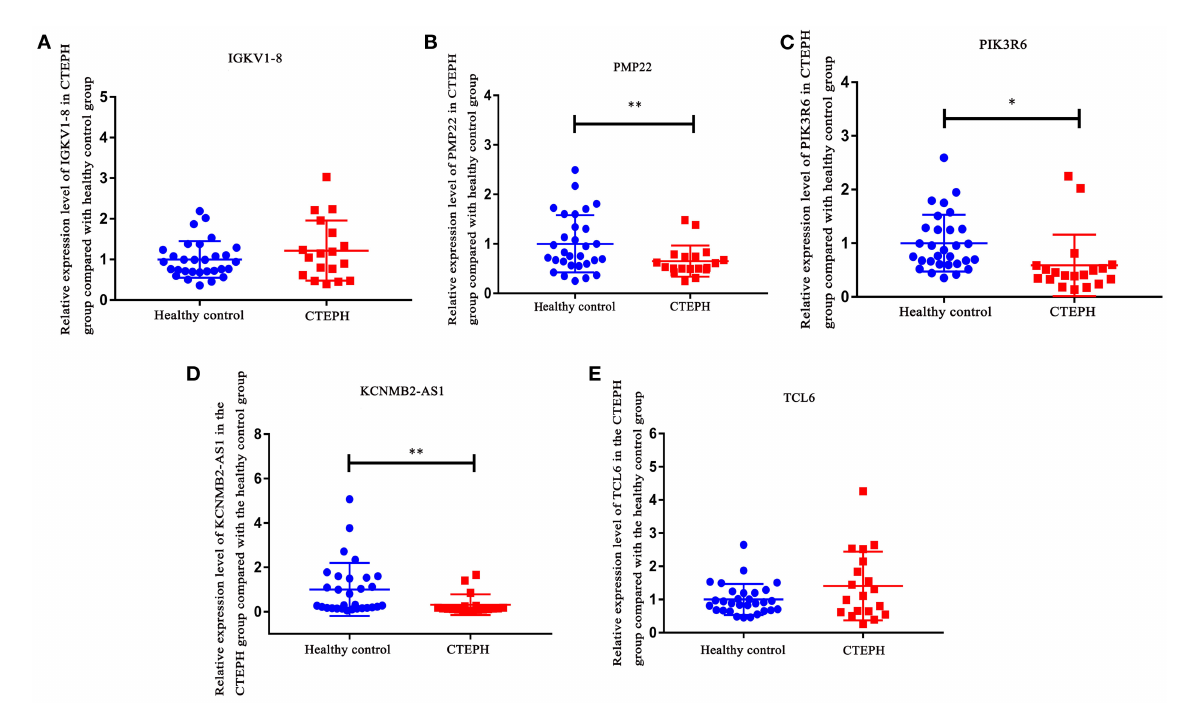
FIGURE8 RT-PCR validation of IGKV1-8 (A) , PMP22 (B) , PIK3R6 (C) , KCNMB2-AS1 (D) , and TCL6 (E) in blood samples. In comparison with the healthy controls, the expression levels of IGKV1-8 and TCL6 in CTEPH group were upregulated trend and PMP22, PIK3R6, and KCNMB2-AS1 were downregulated trend in CTEPH group. Statistical analysis of RT-PCR results showed that the changes in PMP22, PIK3R6, and KCNMB2-AS1 expression levels were statistically significant ( p < 0.05). The t -test was used to evaluate the statistical significance among the patients with CTEPH and healthy controls. * represents p < 0.05; ** represents p < 0.01. p < 0.05 was considered statistically